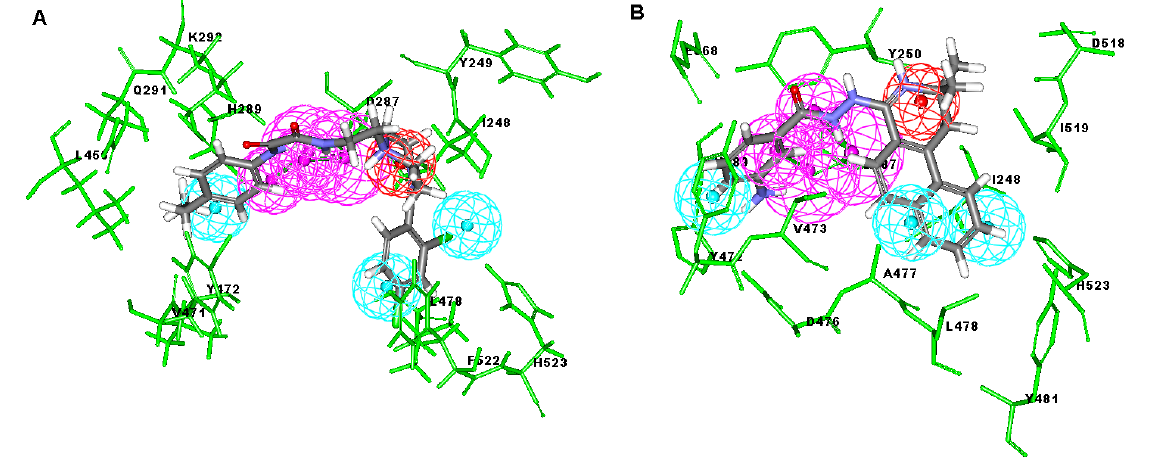
3. Docked binding models of the two representative compounds. ( A ) ZINC06843697; ( B )